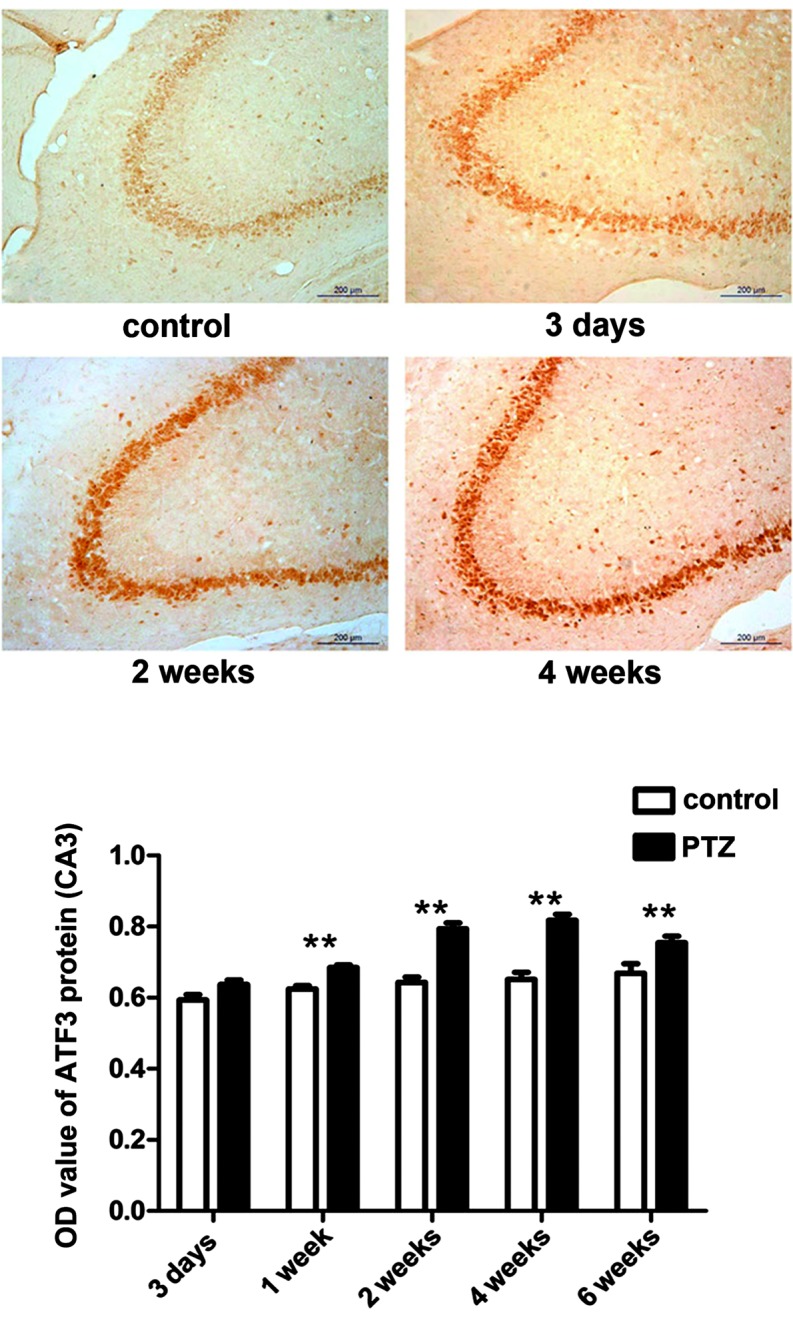
The expression of activating transcription factor 3 (ATF3) in the CA3 area of the hippocampus, as assessed by immunohistochemical staining in the control and the PTZ groups (different time-points post-treatment). The upper panel shows AT3 staining as observed under a fluorescence microscope (magnification, ×100; scale bars, 200 μm). The lower panel shows quantified intensities from 29 PTZ rats and 30 control rats. Compared to the control group, ATF3 expression is significantly increased as early as 1 week post-PTZ injection, reaches a peak at 4 weeks, and shows a slight decline at 6 weeks. **P<0.05.